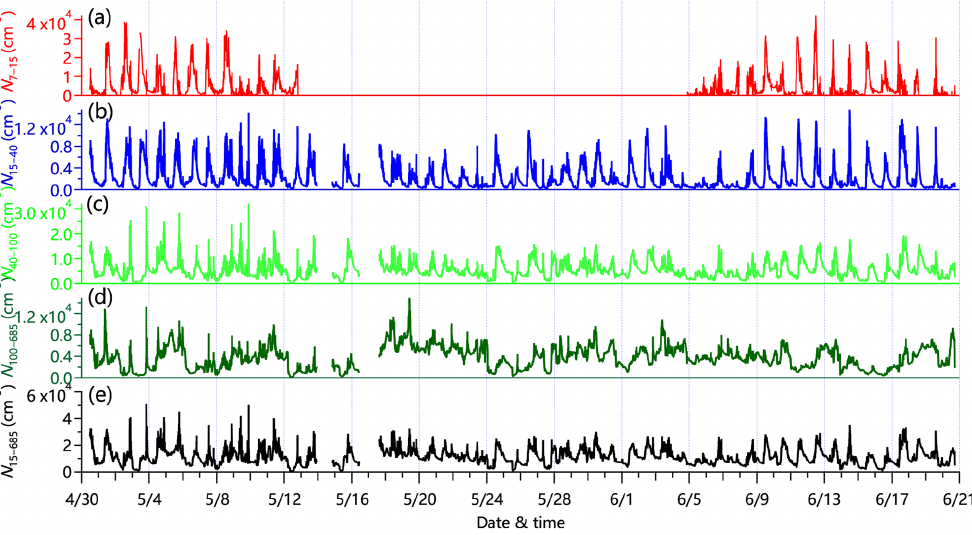
Figure 6. Time series of particle number concentrations for (a) N 7–15 calculated from the differences between MCPC and SMPS measure- ments, (b) N 15–40 (15–40nm), (c) N 40–100 (40–100nm), (d) N 100–685 (100–685 nm), and (e) all particles, N 15–685 (15–685nm). The gap in (a) is mainly due to the malfunction of MCPC during this